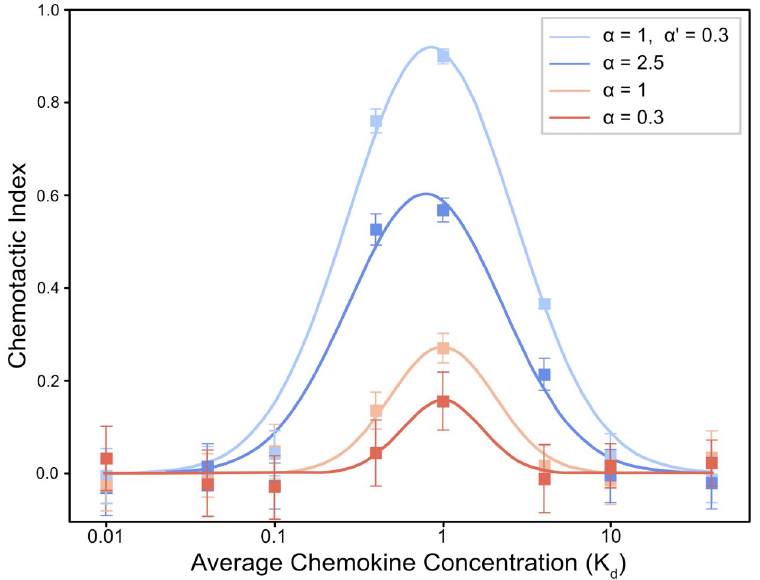
Fig 4. Plot of chemotactic index (CI) as a function of average chemokine concentration, shown for both three individual gradients and for two gradients working together. In all cases, the CI is a maximum when the average chemokine concentration is equal to the K d , while returning to zero at concentrations well above and below the K d . In addition, CI scales with relative strength of the gradient: stronger gradients lead to larger vales of CI, and also a wider range of concentrations over which CI is high. In the case of a coincident gradient, the effect of combining two gradients of relative strength of 1 and 0.3 is much greater than would be predicted by simply adding their CIs. Values are plotted as mean ±